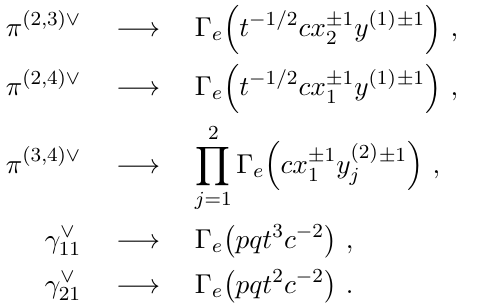
h i h i d (1) d (1) and Tr 2 d (2) d (2) [1 2] [1 2]